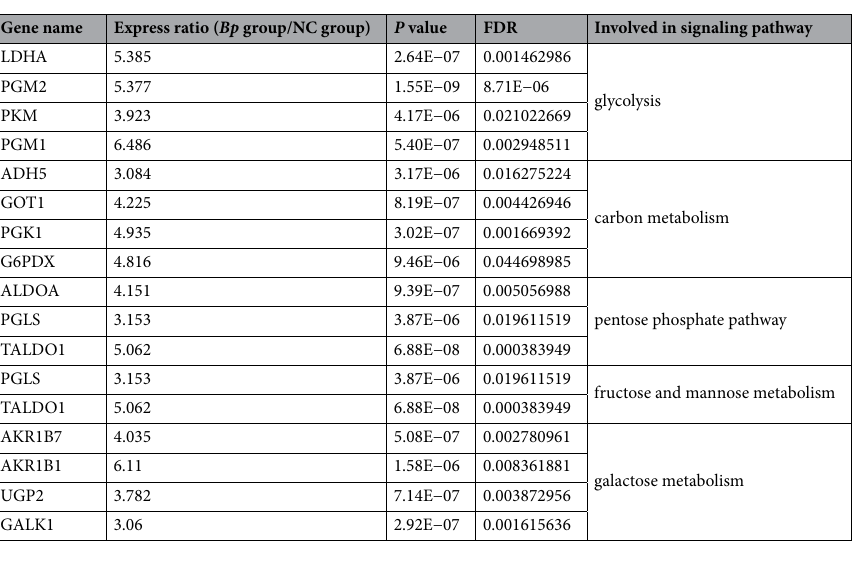
Table 1. Chnage of proteins involved in glycometabolism pathways.